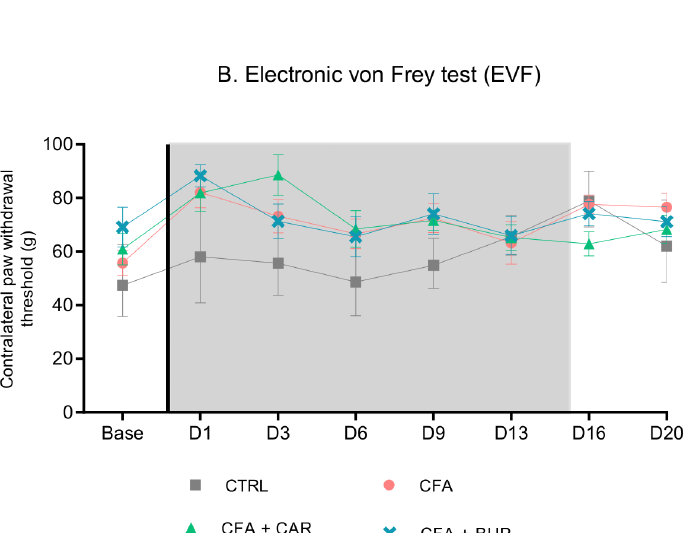
PLOS ONE | https://doi.org/10.1371/journal.pone.0260356 January 13,